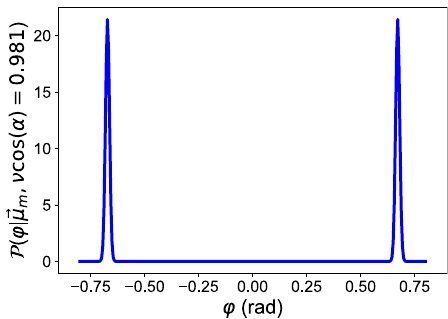
Fig. 4 | Photon detection probability of one of the detectors, as a function of the applied phase α , which is adjusted using the distance of the air-gap. The data shown are for ϵ =0.5, for physical separations of 1.5×10 − 5 m and 6.0×10 − 5 m; the angular separations are 1.48×10 − 5 rad and 5.9×10 − 5 rad,